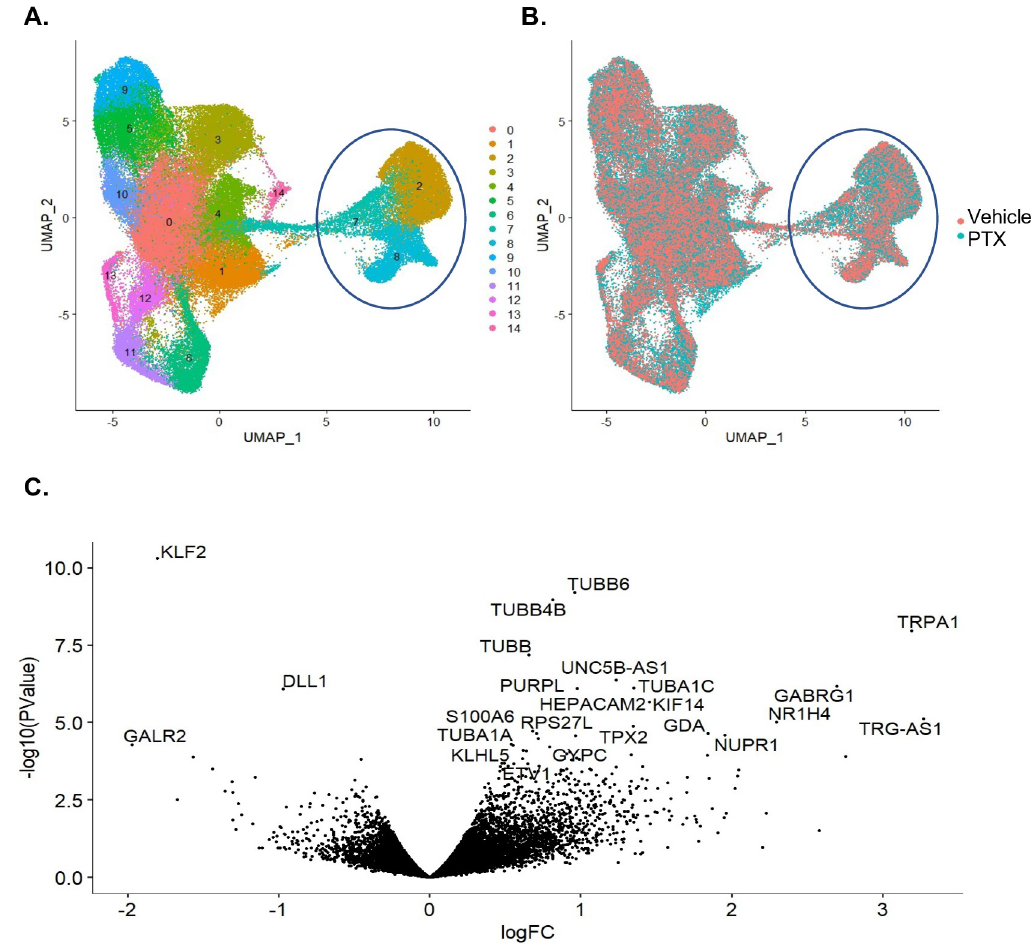
Fig 5. scRNA-seq identifies paclitaxel-induced transcriptomic changes in iPSC-dSN. A) Uniform Manifold Approximation and Projection (UMAP) plot of single-cell transcriptomes. Seurat 3 identified 15 clusters (0–14). B) Overlapping distribution of clustered cells by treatment. Clusters 2, 7, and 8 are characterized as mature sensory neurons and are circled in plots (A) and (B). C) Volcano plot highlighting significant gene expression changes between paclitaxel and vehicle treatment of clusters 2, 7, and 8. A total of 16,601 differentially expressed genes were identified; 21 genes were significantly up-regulated, and 3 genes were significantly down-regulated in the paclitaxel-treated cells (FDR < 0.05). Data obtained from sequencing four iPSC-dSN cell lines. (PTX = paclitaxel, LogFC = log fold-change, FDR = false discovery